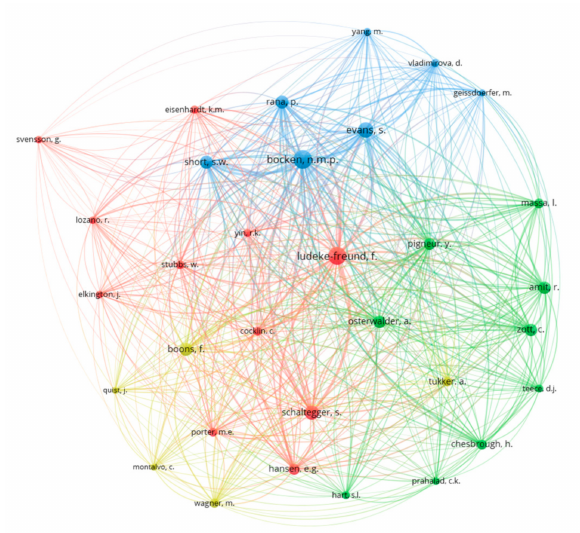
Figure 5. Co-citation of researchers cited in sustainable business models research. Source: own elaboration based on the VOSviewer